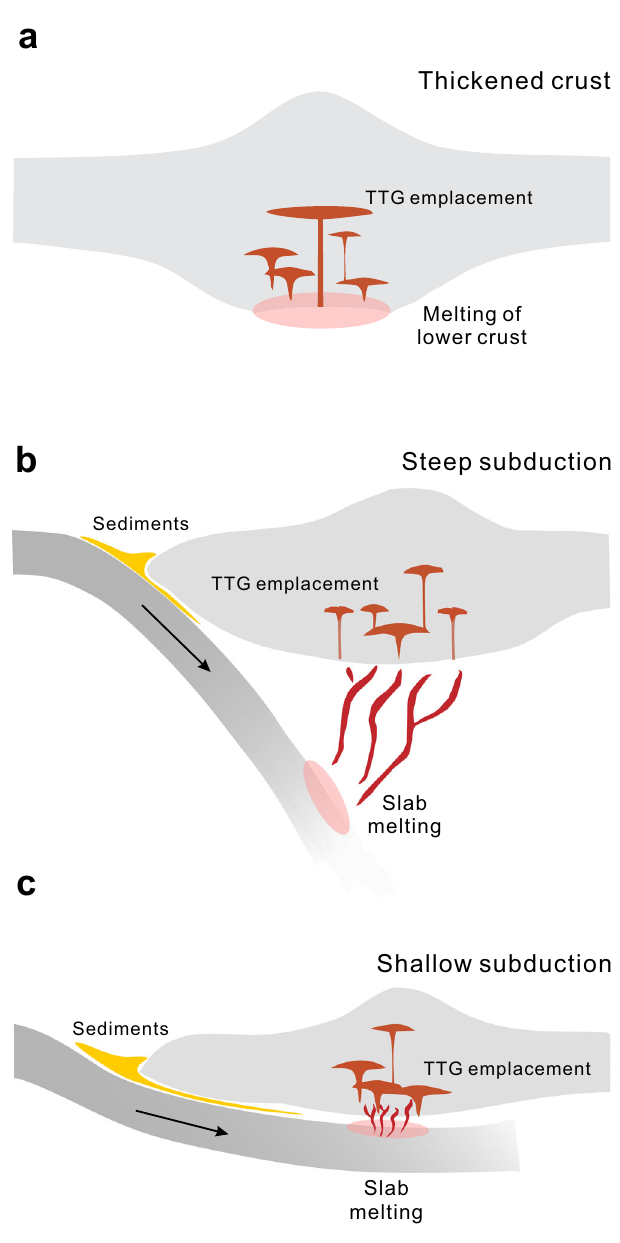
Fig. 1 Cartoon (not to scale) showing three different geodynamic settings for Archean TTG magma genesis. a Melting of ma fi c rocks at the base of oceanic plateau/thickened crust; Slab melting at a convergent plate boundary at ( b ) steep and ( c ) shallow dip angles (after Palin et al. 26